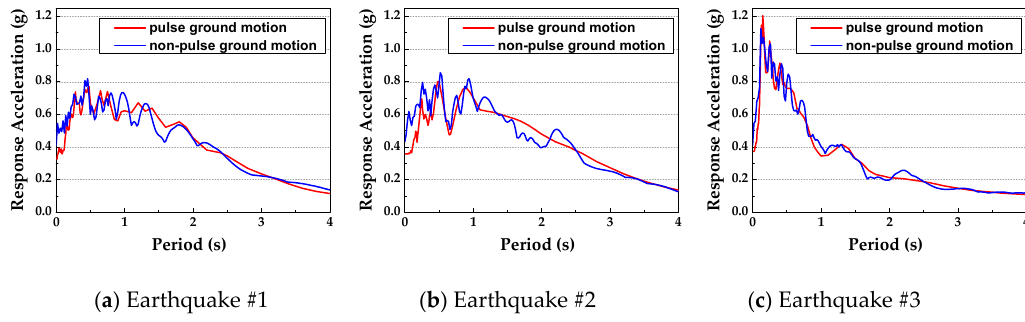
Figure 2. Acceleration response spectra for selected near-fault seismic motions.